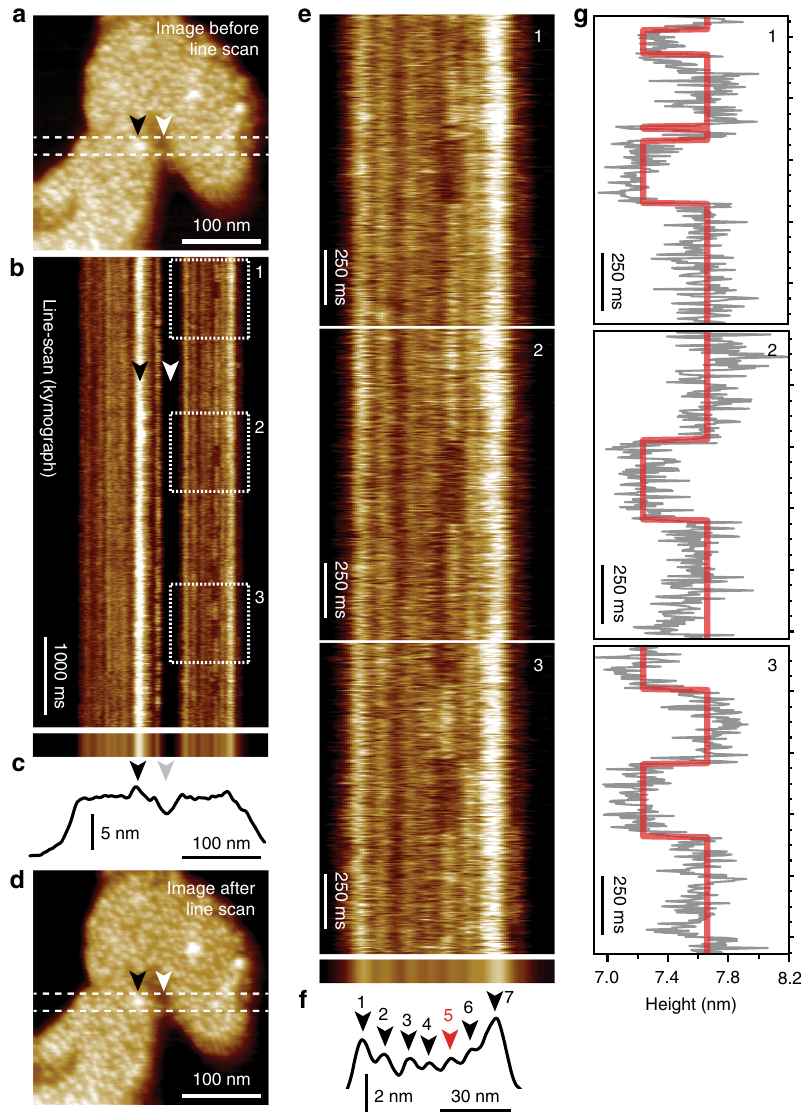
Fig. 2 HS-AFM line scanning (HS-AFM-LS): millisecond temporal resolution of unlabeled transporter dynamics. a HS-AFM image of a membrane packed with Glt Ph exposing the extracellular face before HS-AFM-LS (apo condition: 20 mM Tris-HCl, pH7.5, 150 mM KCl). Dashed lines indicate the position of the central scan line where subsequent HS-AFM-LS is performed. b Six seconds of a HS-AFM-LS kymograph with 3.3 ms line acquisition speed. Each transporter domain appears as a vertical line. c Projection (top) and height pro fi le (bottom) of b . d HS-AFM image after HS-AFM-LS. The lateral position of recognizable features in a – d are indicated by arrowheads. e One second high-magni fi cation views of dashed regions 1, 2, and 3 in b . Transport domain excursions to the inward-facing state appear as dark dwells along the vertical time axis. f Projection (top) and height pro fi le (bottom) of e . Arrowheads indicate the position of the seven protomers in the kymograph (red: active protomer #5). g Height/time traces (gray) and state fi ts (red) of the active domain (protomer #5) in e . This fi gure is representative of the experimental sequence for the >50 replicates analyzed in this